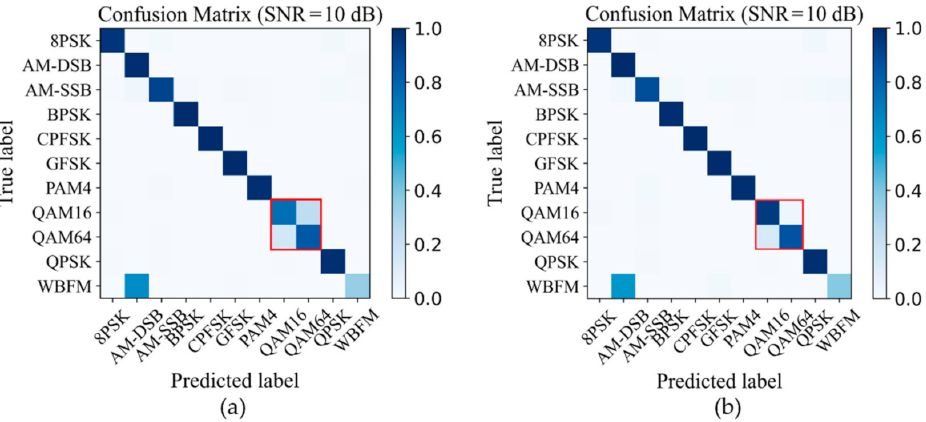
Figure 9. Confusion matrixes of the two methods: ( a ) IQCLNet network; ( b ) the joint AMC model. Due to the limitations of volume, mass, and power consumption, and the influence of environmental factors such as space radiation and extreme temperature, the computing power and storage space of space-borne computers are very different from those of ground- based computers. Although deep neural networks have the advantages of strong feature extraction ability and high recognition accuracy, they also have the disadvantages of many network parameters and a large amount of calculation. Therefore, we compare the number of parameters and training time of all networks, and the experimental results are shown in Table 4. Compared with other networks, our proposed IQCLNet network has fewer parameters and higher computational efficiency, which is more conducive to deployment to satellite in-orbit